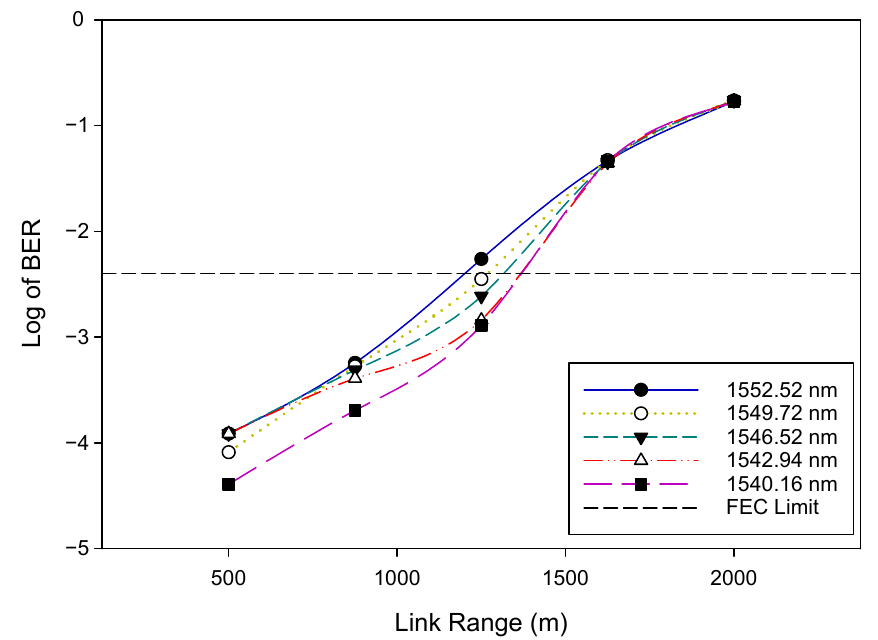
Figure 8. BER versus Link range plots for